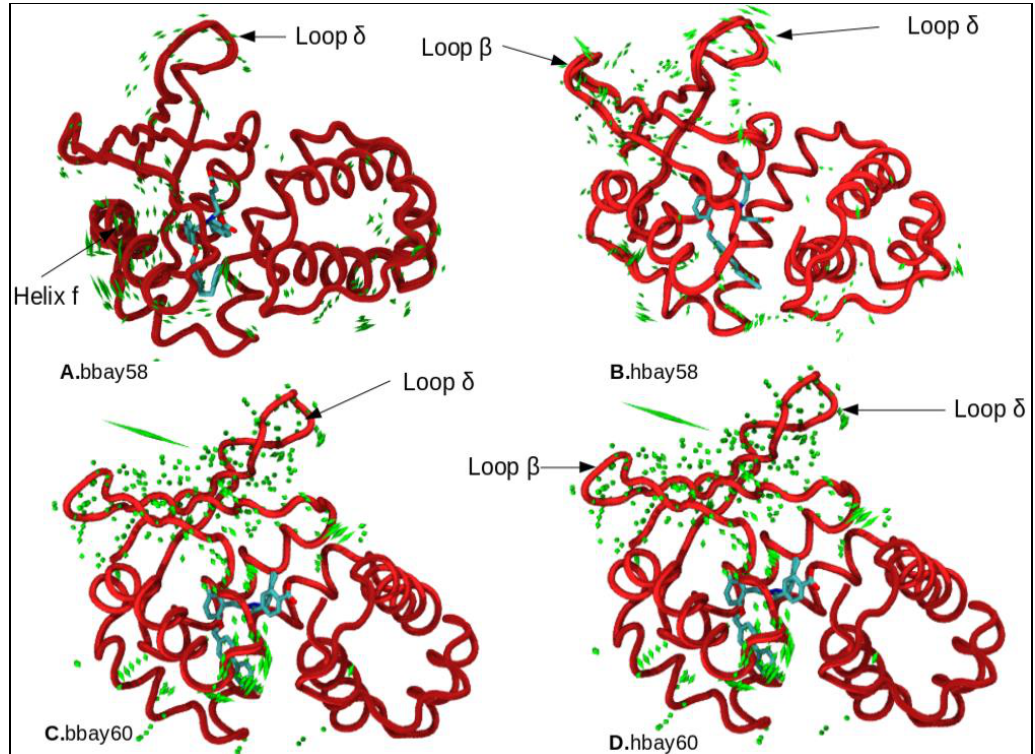
Figure 8. Uncorrelated trajectories Analysis through essential dynamics depicted by the porcupine plot of ( A ) bacterial H-NOX bound BAY58-2667 (bbay58), ( B ) human H-NOX bound BAY58-2667 of ( A ) bacterial H-NOX bound BAY58-2667 (bbay58); ( B ) human H-NOX bound BAY58-2667 (hbay58); (hbay58), ( C ) bacterial H-NOX bound BAY60-2770 (bbay60), and ( D ) human H-NOX bound BAY60- ( C ) bacterial H-NOX bound BAY60-2770 (bbay60); and ( D ) human H-NOX bound BAY60-2770 (hbay60) 2770 (hbay60) respectively. Green color porcupines represent those regions which respectively. Green color porcupines represent those regions which experienceconsiderable experienceconsiderable movement. All dynamically important regions which showed changes during principle component analysis are further highlighted with arrows.